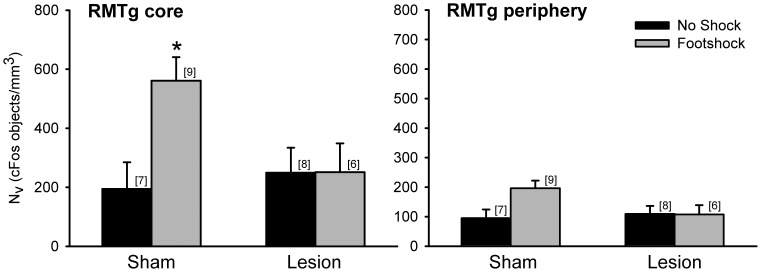
cFos positive objects in the RMTg of rats exposed to low-intensity footshock.Exposure to shock elevated cFos expression in the RMTg. Lesions of the fr prevented the increase in shock-induced cFos expression in the RMTg core; shocked sham rats showed significantly elevated cFos expression (*, Tukey, p<0.05) relative to the other three conditions. In this and in all subsequent figures the number of subjects per group are indicated above each bar.